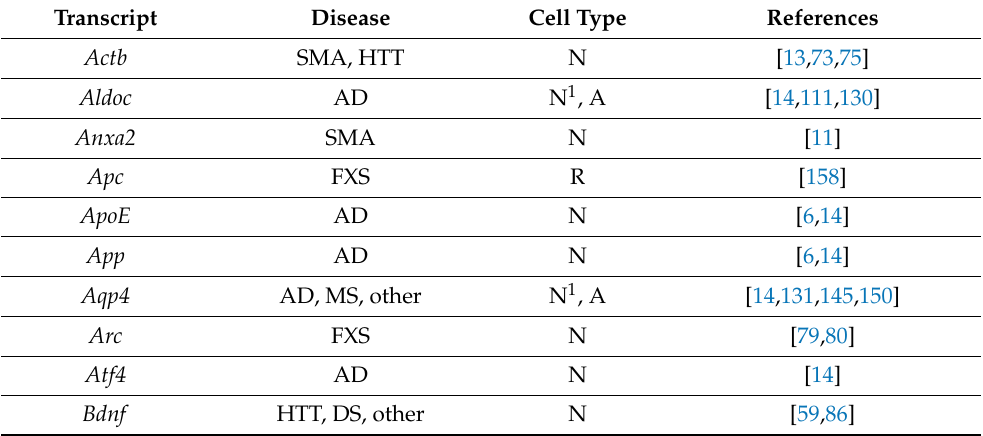
Table 2. List of RNAs and RBPs whose localization and /or local translation is proven or suggested to be linked to neurological and/or neurodegenerative diseases. AD, Alzheimer’s disease; ALS, Amyotrophic lateral sclerosis; ASD, Autism spectrum disorder; DS, Down syndrome; FTD, Fron- totemporal dementia; FXS, Fragile X syndrome; HD, Huntington’s disease; MS, Multiple sclerosis; SMA; Spinal muscular atrophy. Others include stroke, dementia, intellectual disabilities and neu- rodevelopmental disorders. N, neurons; A, astrocytes; R, radial glia; O, oligodendrites. N 1 refers to significantly changed transcripts in A β -treated axons vs. controls that have not been further referred to in the literature and are thus not included in Figure 2. MS 2 includes MS and demyelination. List of mRNAs/microRNAs Localized to Subcellular Compartments in Neurons and Glia